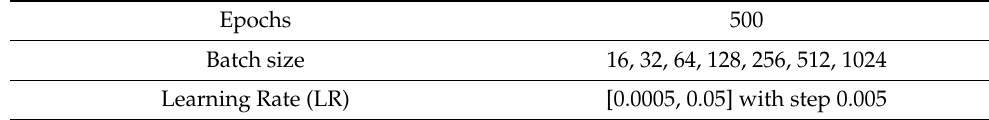
Table 4. Hyperparameters of the ANN model.